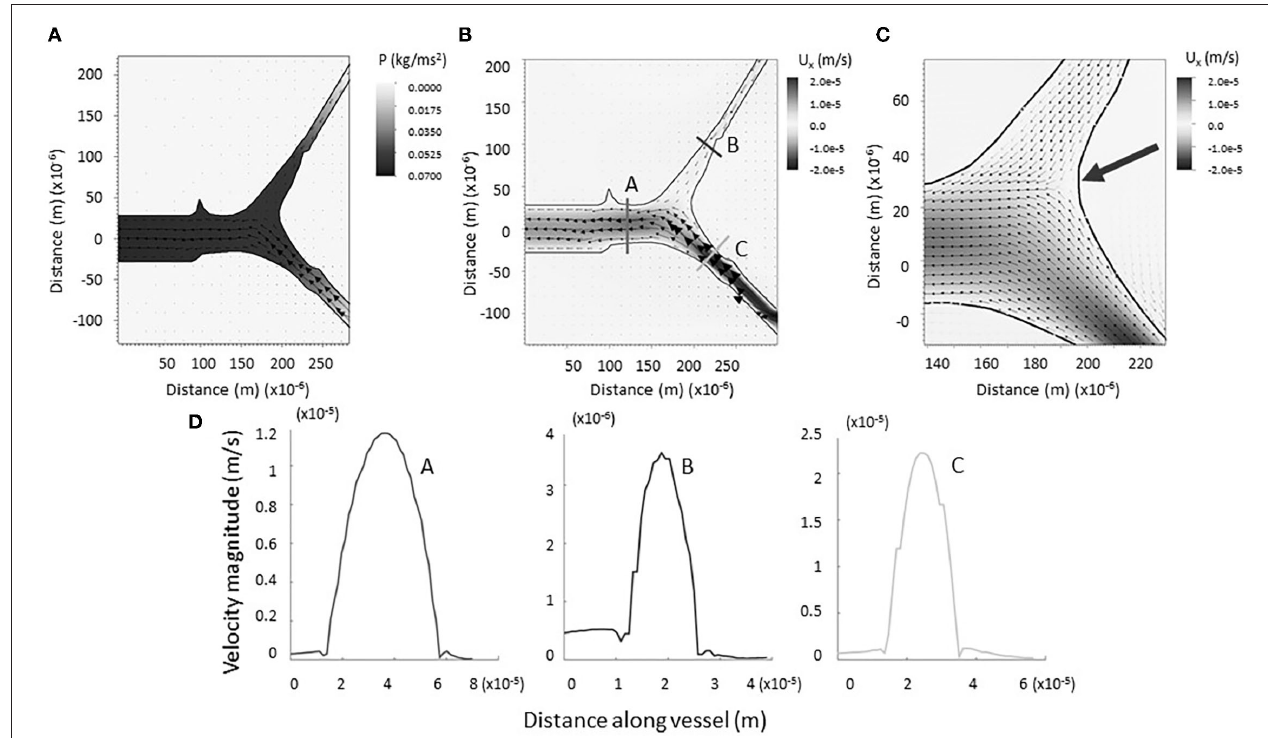
FIGURE 3 | (A) Computational model of lymph flowing through x = 1 junction. Note the formation of a negative pressure gradient (heat map) driving the flow of lymph as it is drawn into the vessel. Vectors represent fluid velocity. (B) Computational model of lymph flowing through x = 1 junction. No regions of backflow are evident. Vectors represent fluid velocity, and the heat-scale map shows the horizontal component of the flow. (C) Bifurcation of the vessels is marked by a stagnation point (large arrow). (D) Magnitude of flow velocity taken along cross sections shown in B. This verifies that flow is nearly parabolic within the vessels (coded by lettering).